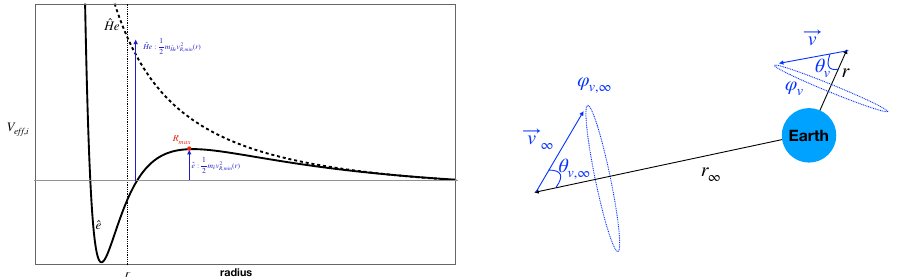
Figure 8 . On the left is an illustration of the one dimensional effective potentials for positively and negatively charged mirror particles induced by a net captured positive charge inside the Earth (shown for ˆHe ++ as a dashed line and for ˆe − as a solid line). The one dimensional effective potential for negatively charged particles exhibits a local maximum where the repulsive force from angular momentum exactly balances the mirror electrostatic attraction. In this case for an incoming particle to reach any point deeper than R , the location of the maximum of the barrier, the radial kinetic max energy at infinity must be greater than the height of the barrier at R . For the case of positively max charged particles no such barrier exists. Then, to reach any point r , it suffices for the radial kinetic energy of the incoming particle at infinity to be greater than the effective potential at r . On the right we illustrate our choice of coordinates for the velocity